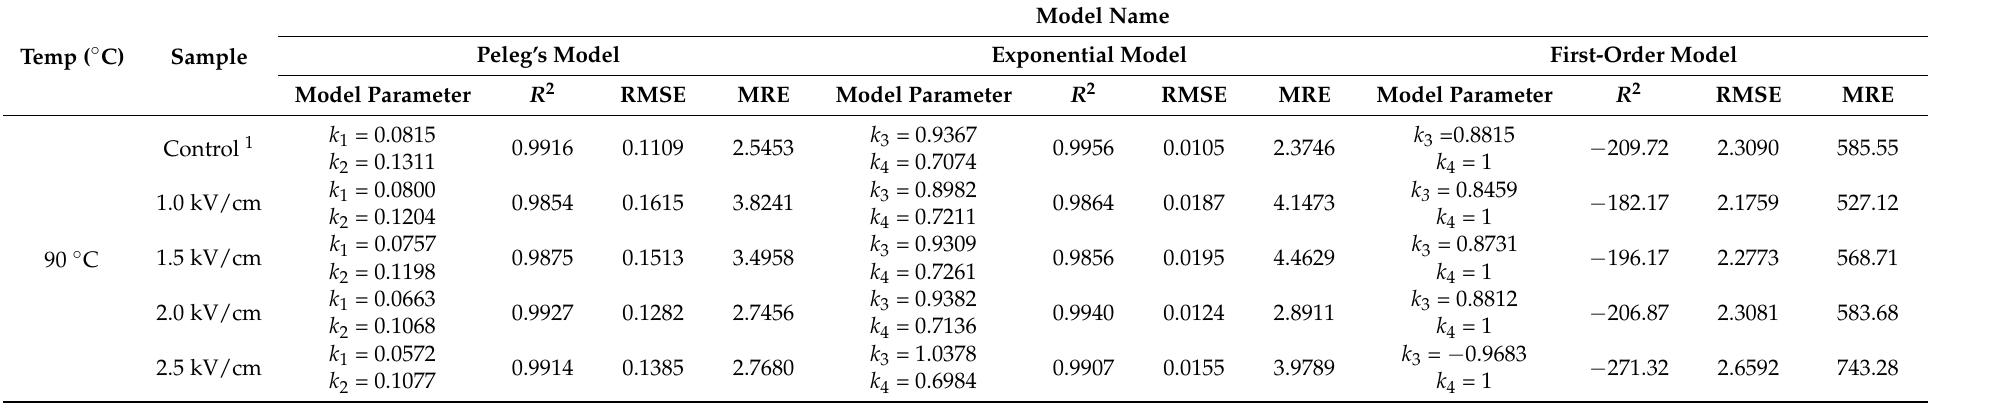
Table 2. Peleg’s model, exponential model, and first-order model constant at different strengths of